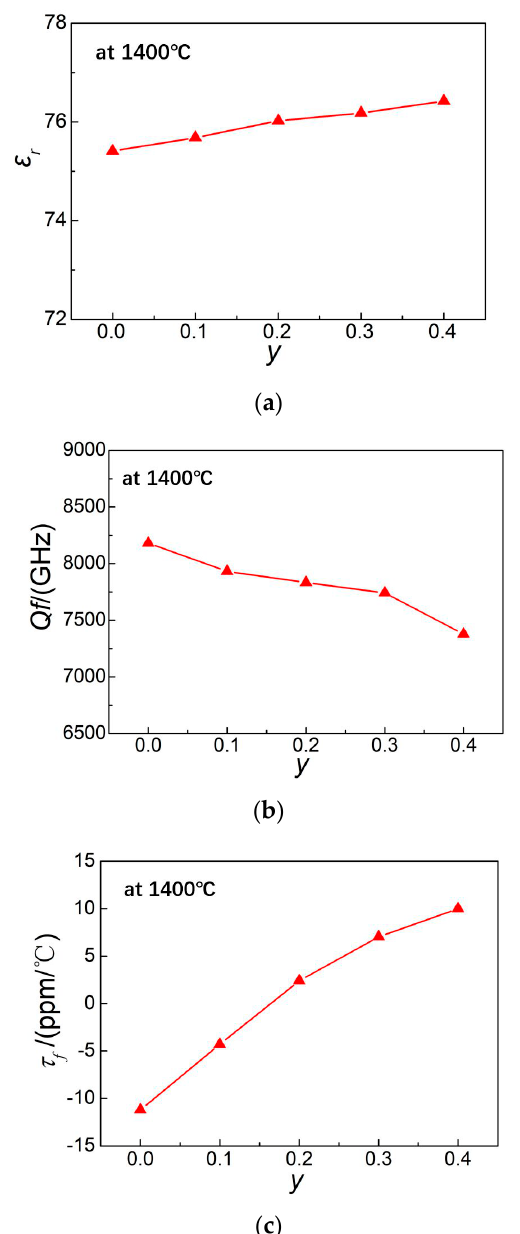
Figure 4. The relationship between Nd content and microwave dielectric properties: ( a ) dielectric constant; ( b ) quality factor and ( c ) temperature coefficient of Ba 6 − 3 x (Sm 1 − y Nd y ) 8+2 x Ti 18 O 54 ( x = 2/3) ceramics sintered at 1400 °C.